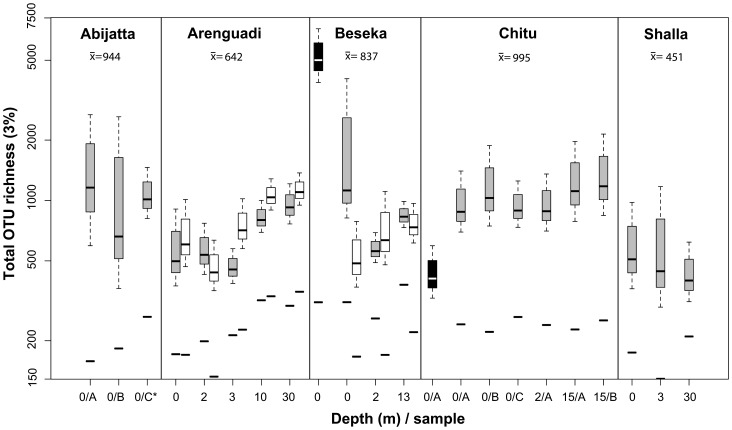
Parametric richness estimates.Box-plots cover 95% Bayesian confidence intervals of total OTU richness for each sample. Grey boxes indicate DNA amplicon datasets, white boxes cDNA amplicons and black boxes DNA amplicon datasets derived from prefilters. Solid lines below the box plots indicate rarified OTU richness. Arithmetic means of medians for DNA amplicon datasets (excluding prefilter-derived) are shown below lake names.